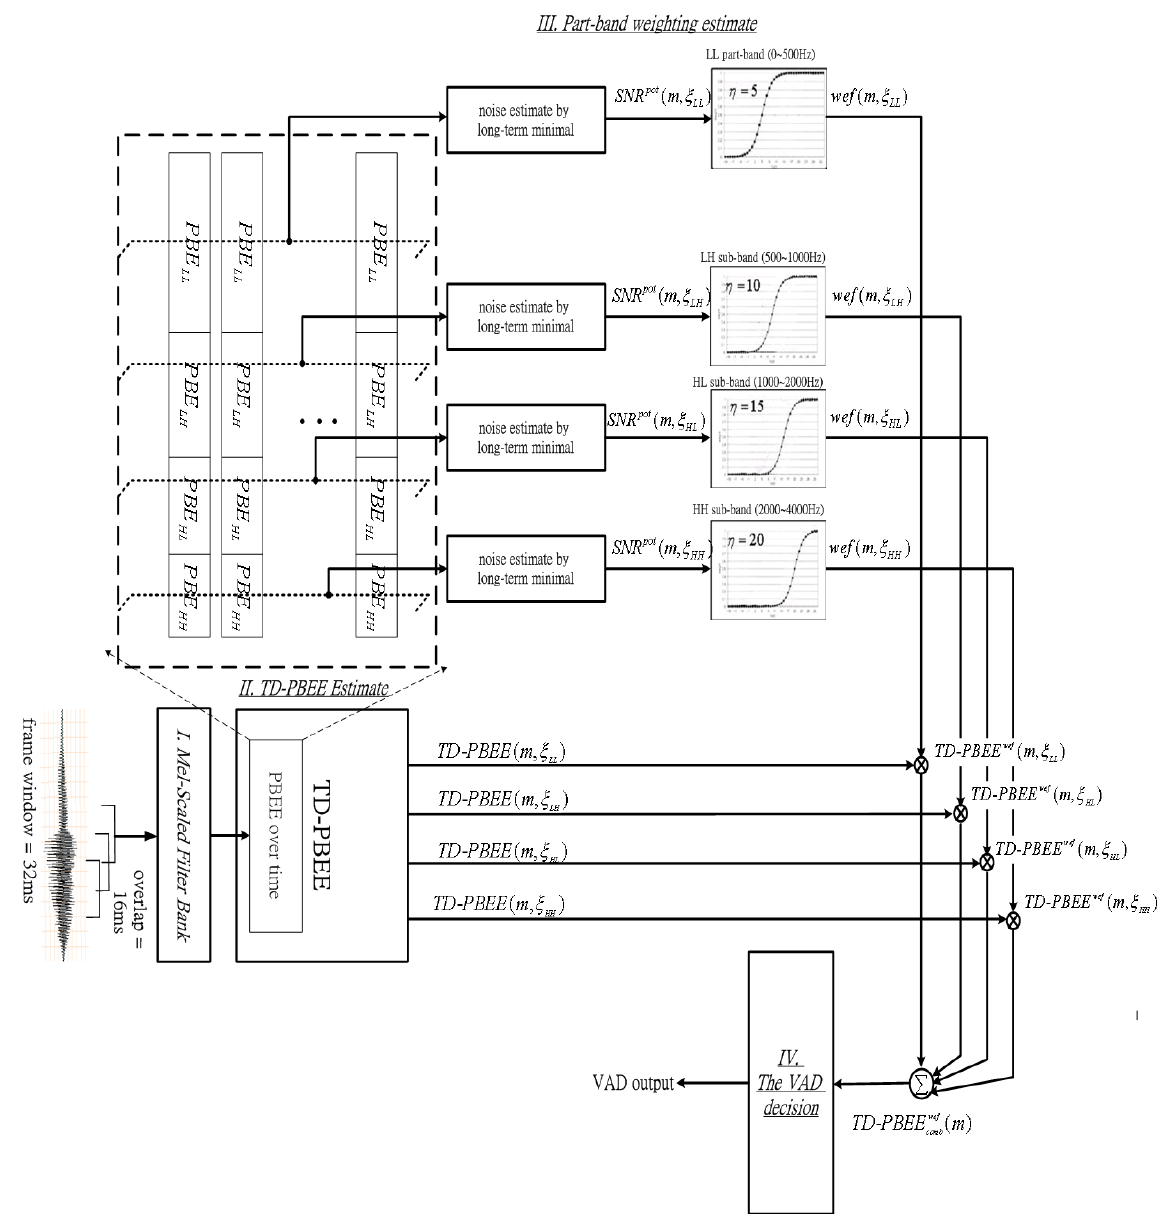
Figure 5. The block diagram of TD-PBEE based VAD